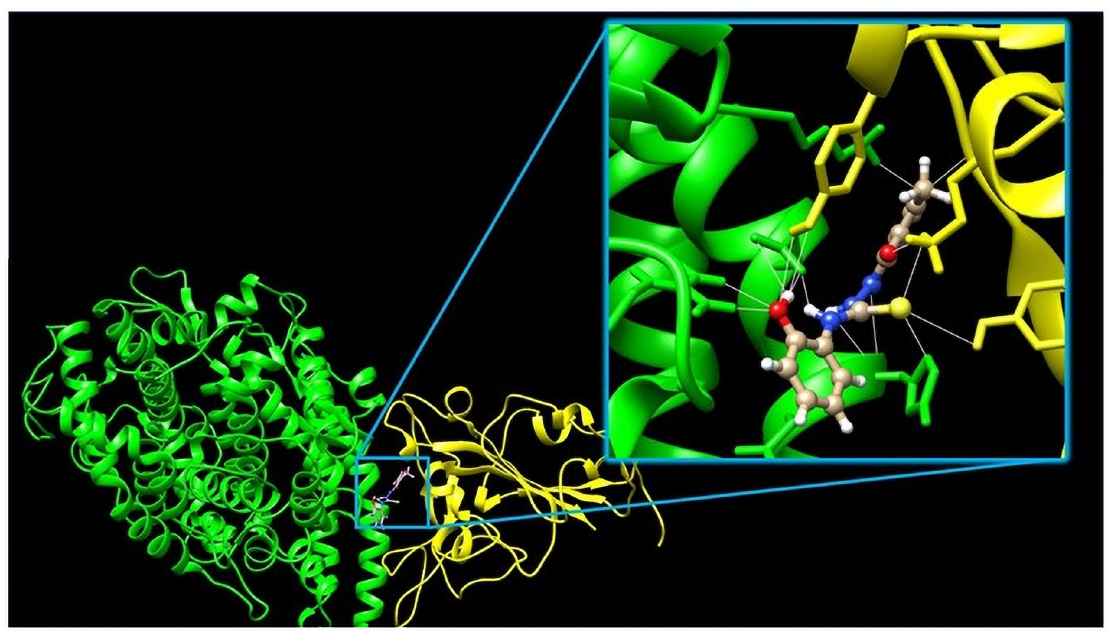
Fig 3. The orientation of the best result of the consensus docking (see the first line of Table 3) at the SARS-CoV-2 S-protein (yellow)— ACE2 receptor (green) interface. The insert shows the closest environment of the docked compound and the hydrogen bonding network.